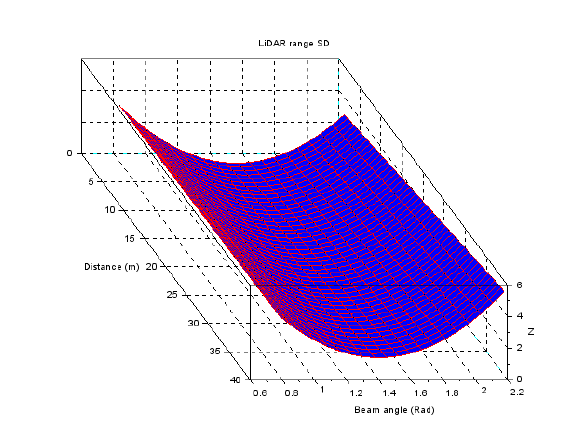
Figure 3. Standard deviation of the LiDAR range return as a function of the range ( ρ ) and of the beam angle ( α